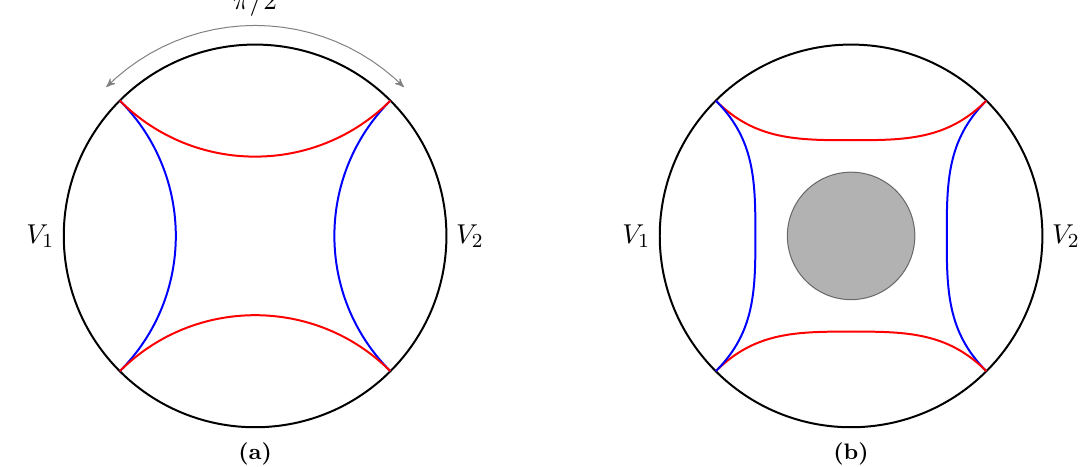
Figure 9. A counterexample to the converse of Theorem 1. (a) A scattering con(cid:12)guration in vacuum AdS 2+1 is chosen so that the restriction of V 1 [ V 2 to a spacelike slice is Z 2 symmetric with its complement. The scattering region J 12 ! 12 consists of a single point, and the entanglement wedge of V 1 [ V 2 becomes connected under any small enlargement of the region. (b) When spherically- symmetric matter with positive null energy is added to the bulk, time delay destroys the region J 12 ! 12 . However, V 1 and V 2 are still symmetric with their complement; under an in(cid:12)nitesimally small perturbation, the entanglement wedge can become connected while the scattering region stays